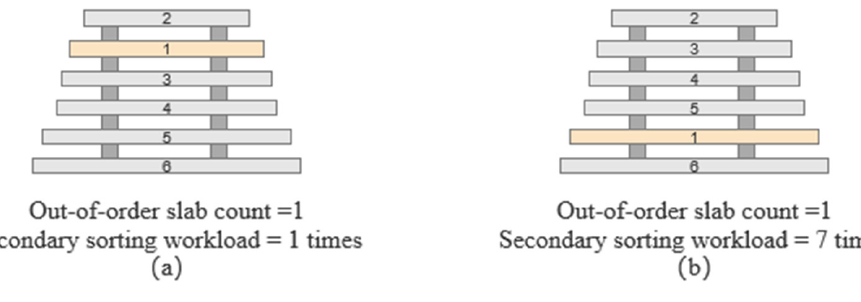
Figure 3. Examples of stacks with the same number of slabs outside sequence but different secondary-sorting workloads.